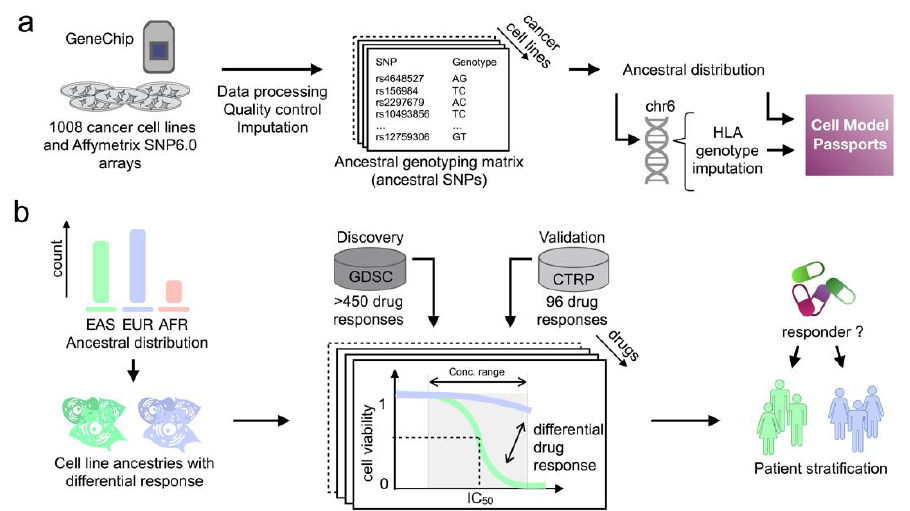
Figure 1. Ancestry inference pipeline and downstream analysis for differential drug response. ( a ) The analysis pipeline for retrieving an ancestral genotyping matrix by using Affymetrix SNP6.0 arrays from the GDSC CCLs, including data processing, quality control and imputation. The inferred ancestry and HLA genotypes are deployed on Cell Model Passports. ( b ) Workflow of pairwise ancestral comparisons of drug response in GDSC, validated with CTRP, generating hypotheses for patient stratifications in clinical trials based on demographics.